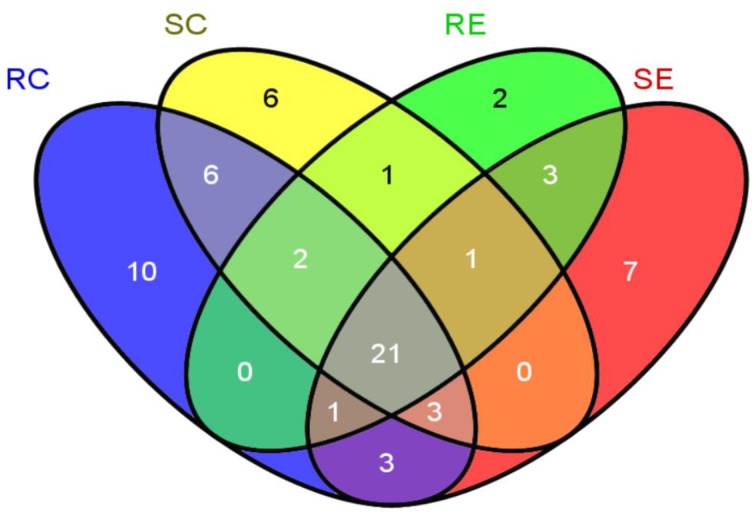
Venn diagram indication of 66 OTUs identified in the four treatment groups.